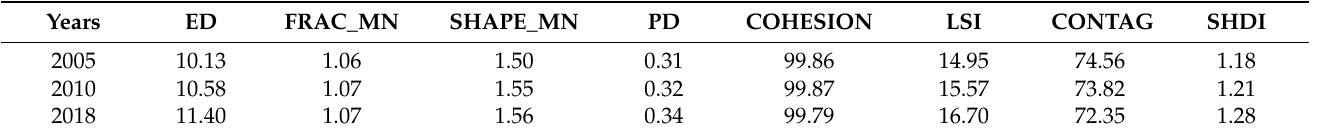
Table 2. Changes in landscape level pattern